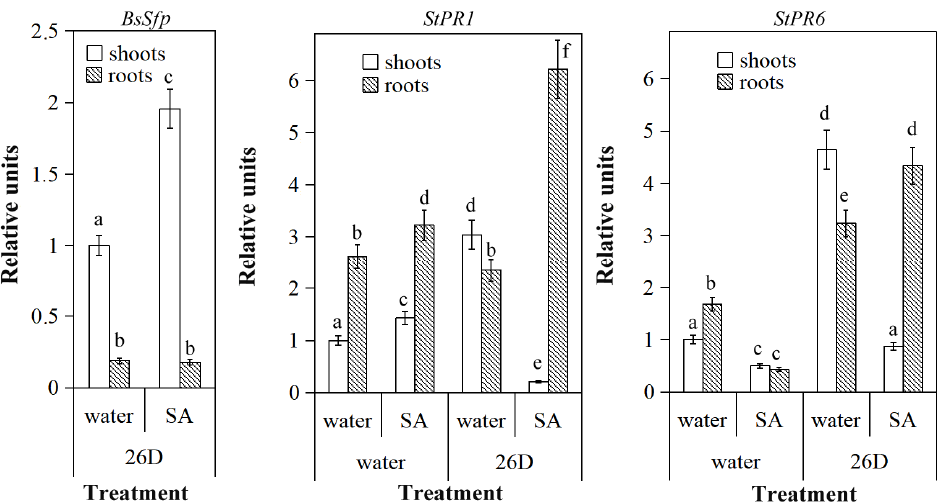
Figure 2. Influence of SA on the activity of transcription of the B. subtilis 26D BsSfp gene (surfactin synthetase), potato genes StPR6 (trypsin inhibitor), StPR1 (basic protective protein) in potato plants 24 h after post-inoculation with B. subtilis 26D suspension. The expression of each target gene is presented as a fold change normalized to the relevant reference gene. Values followed by the same alphabet are not significantly different from each other by Student test p < 0.05.